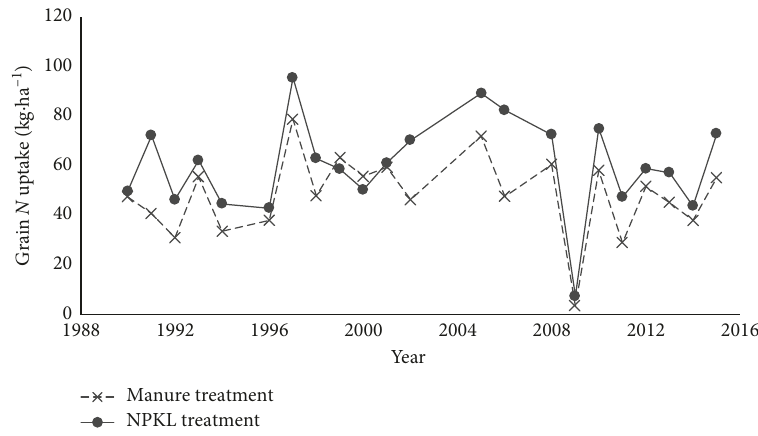
Figure 1: Changes in grain N uptake in manure and NPKL treatments,